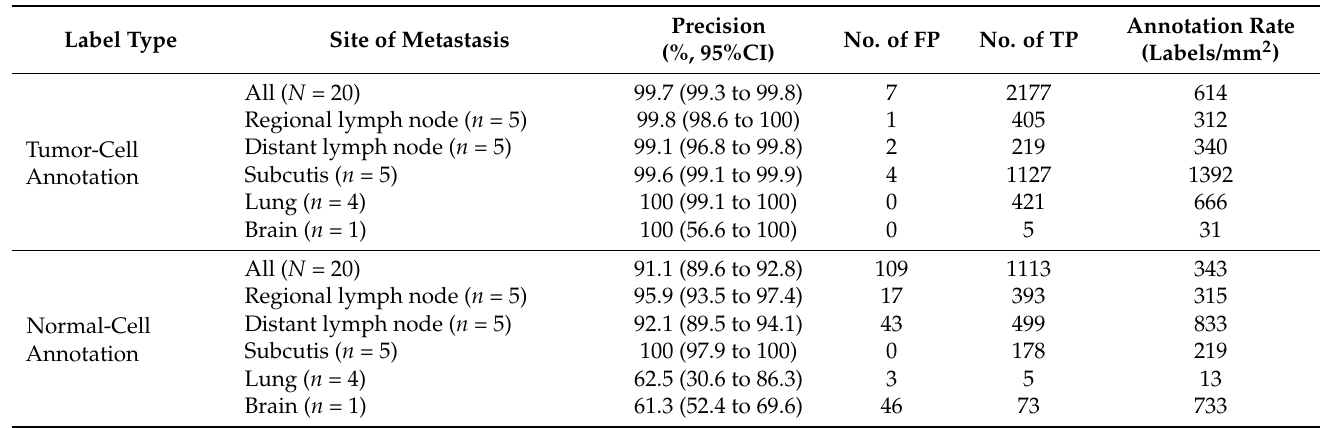
Table 5. Performance of Convolutional Neural Network for Annotation (CNN Ann-H&E/IHC ) in Metastases.